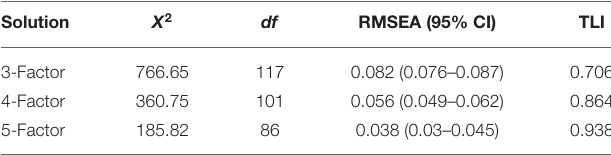
TABLE 4 | Model fit indices for the proposed three, four and five-factor solutions.